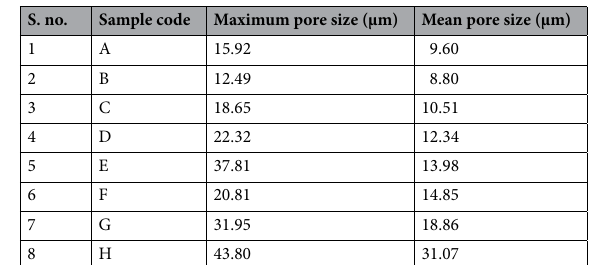
Table 4. Pore size distribution of different MB sample (A–H) showing maximum and mean pore diameter of the filter layer.